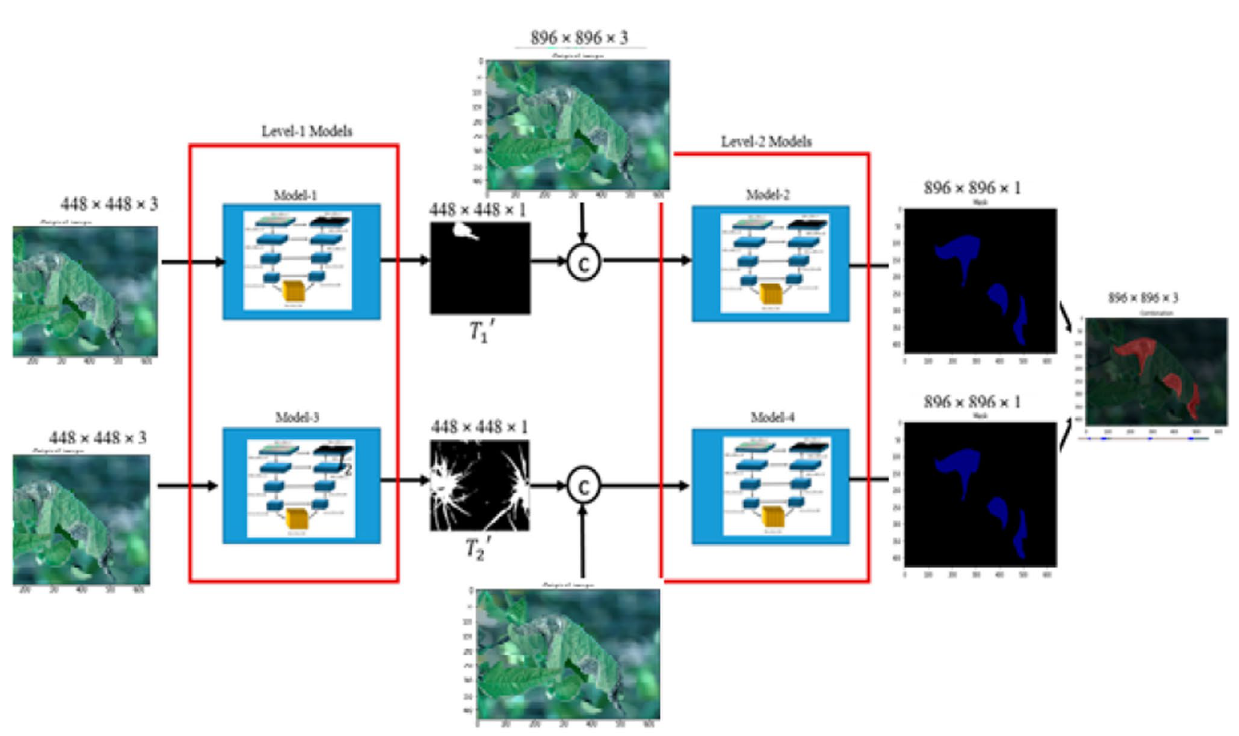
Fig. 10 The architecture of the Ced-Net